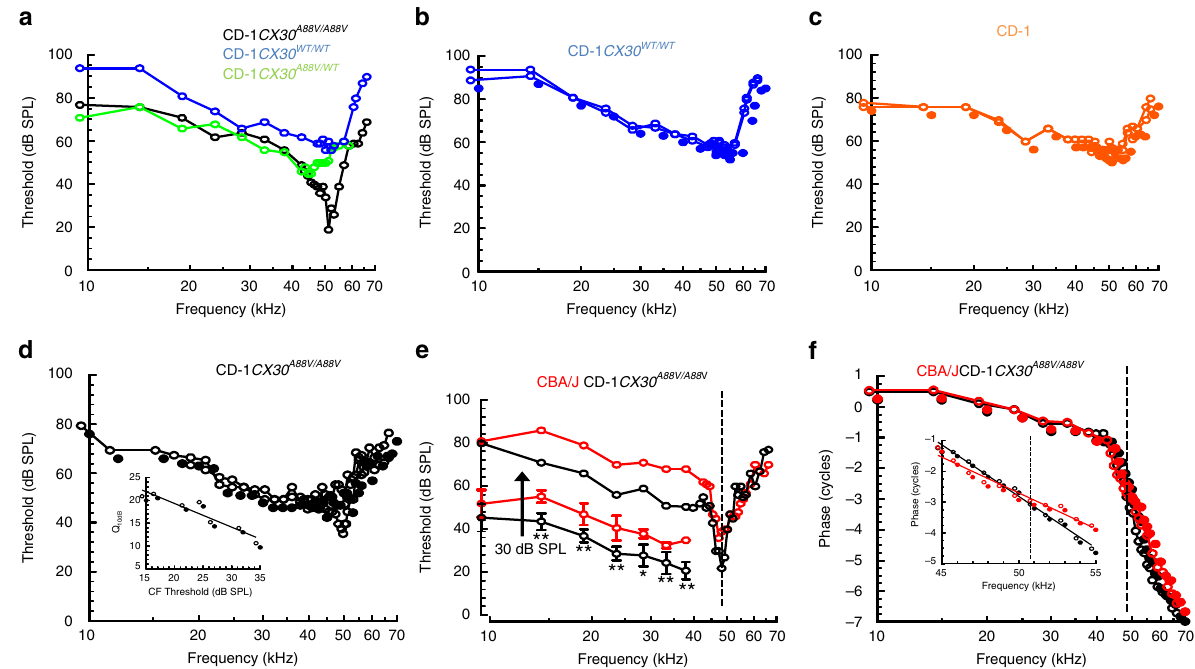
Figure 4 | Basilar membrane displacement frequency tuning curves and phase. ( a – e ) BM displacement threshold (0.2nm criterion) as a function of stimulus frequency measured from the basal turn of the cochlea. Strain and genetic state of individual mice identified in the wording and colour of the captions at the top of each figure (CD-1 Cx30 A88V/A88V (black), CD-1 Cx30 WT/WT (blue), CD-1 Cx30 A88V/WT (green), CD-1 (orange) CBA/J (red)). Curves with solid symbols in b – d are post-mortem measurements from the same preparations. Inset to d : Q 10dB as a function of threshold at the tuning curve tip for CD-1 Cx30 A88V/A88V mice. ( e ) Inset to e : mean ± s.d., n ¼ 5 of the 10–40kHz region of tuning curves for CBA/J and CD-1 Cx30 A88V/A88V . For clarity, the curves are displaced downwards by 30dB SPL. Asterisks: significantly different (unpaired t -test, **0.01, *0.05 two-tailed p value). ( f ) Phase of BM responses (measured at 70dB SPL) (open symbols) as a function of frequency for tuning curves shown in e . Solid symbols, mean ± s.d. of phase (10–45kHz) from five each of CD-1 Cx30 A88V/A88V and CBA/J mice. Inset to f : linear plots of expanded section of curves between 45 and 55Hz. The slopes of regression reveal that the phase of BM responses from the CBA/J mouse decreases by (cid:2) 0.232 ± s.e. 0.014 cycles per kHz and that from the CD-1 Cx30 A88V/A88V mouse decreases by (cid:2) 0.335 ± s.e. 0.011 cycles per